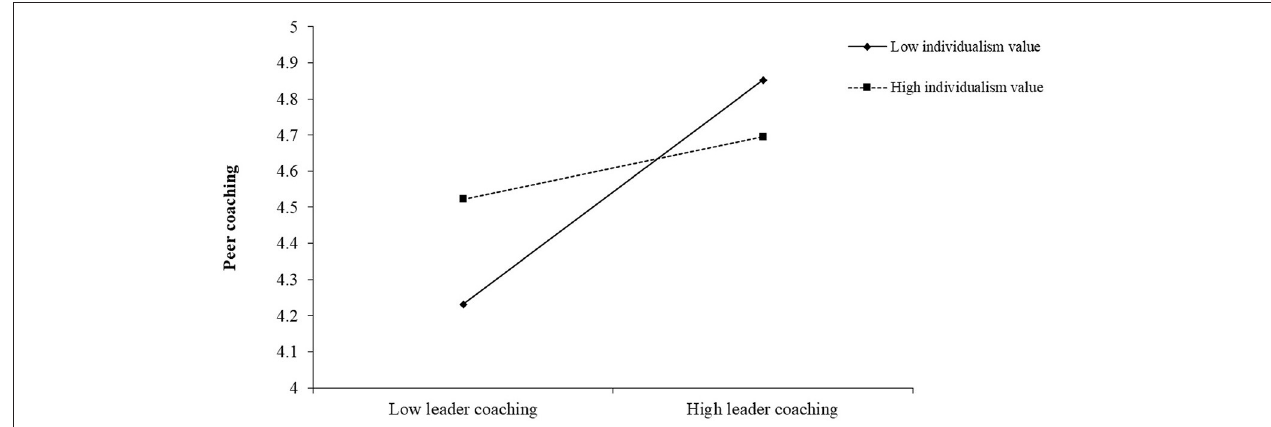
FIGURE 2 | Interactive effect of leader coaching and team individualism/collectivism value on peer coaching.